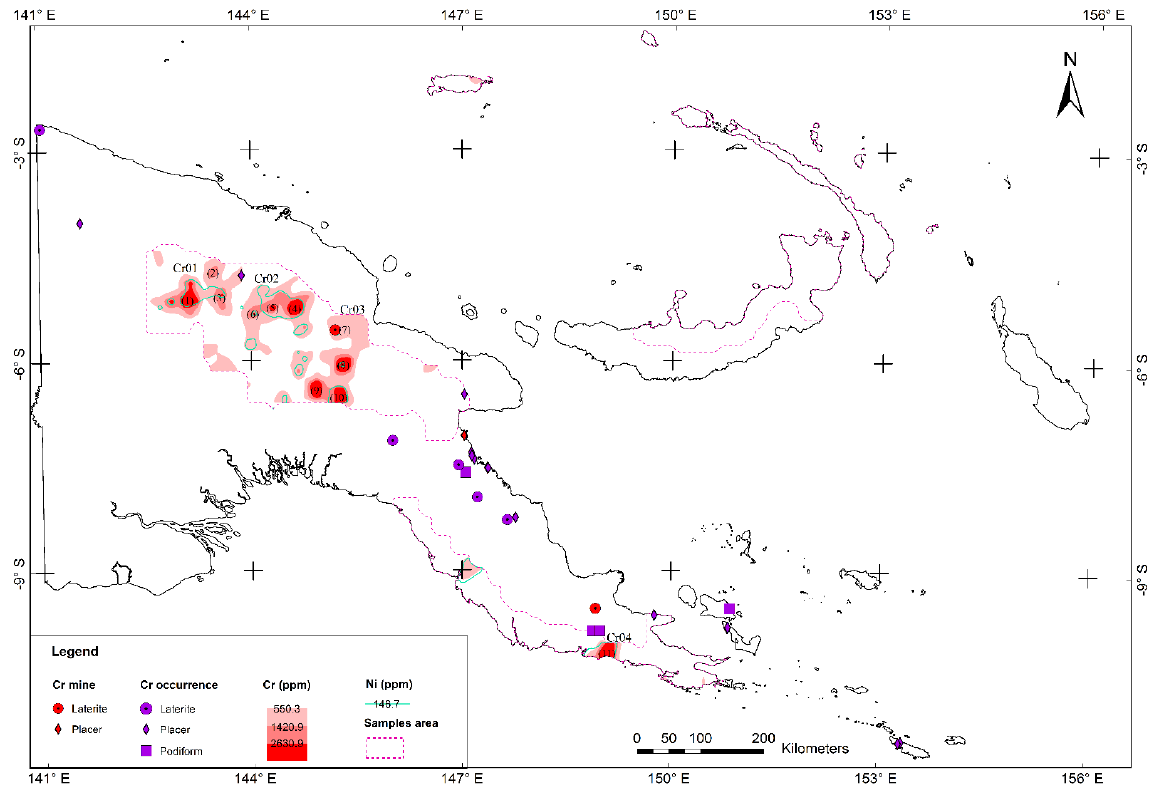
Figure 6. Chromium–nickel integrated anomaly map of PNG.